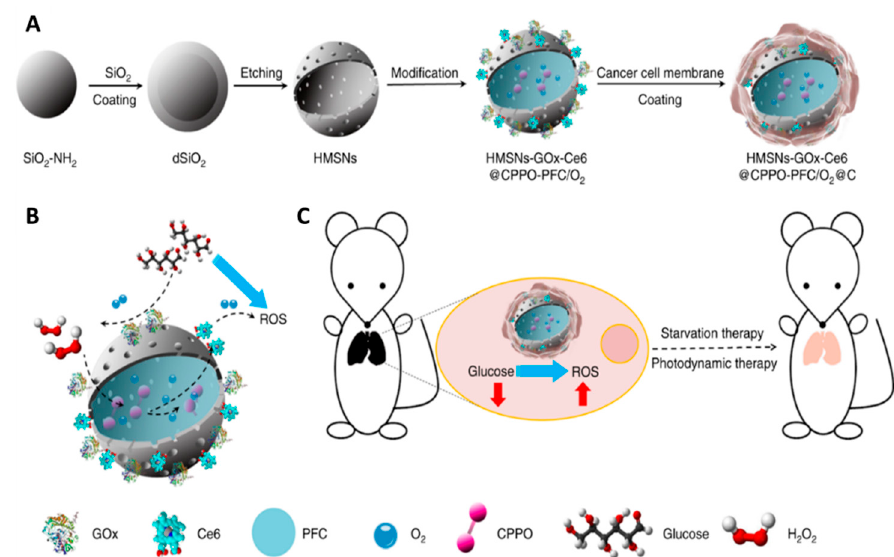
Figure 7. Schematic illustrations of the process for synthesizing a biomimetic nanoreactor: ( A ) ROS generation based on chemiluminescence resonance energy transfer (CRET) with glucose consumption, no light excitation ( B ), and synergetic photodynamic-starvation therapy for metastases ( C ). Reproduced from [115].